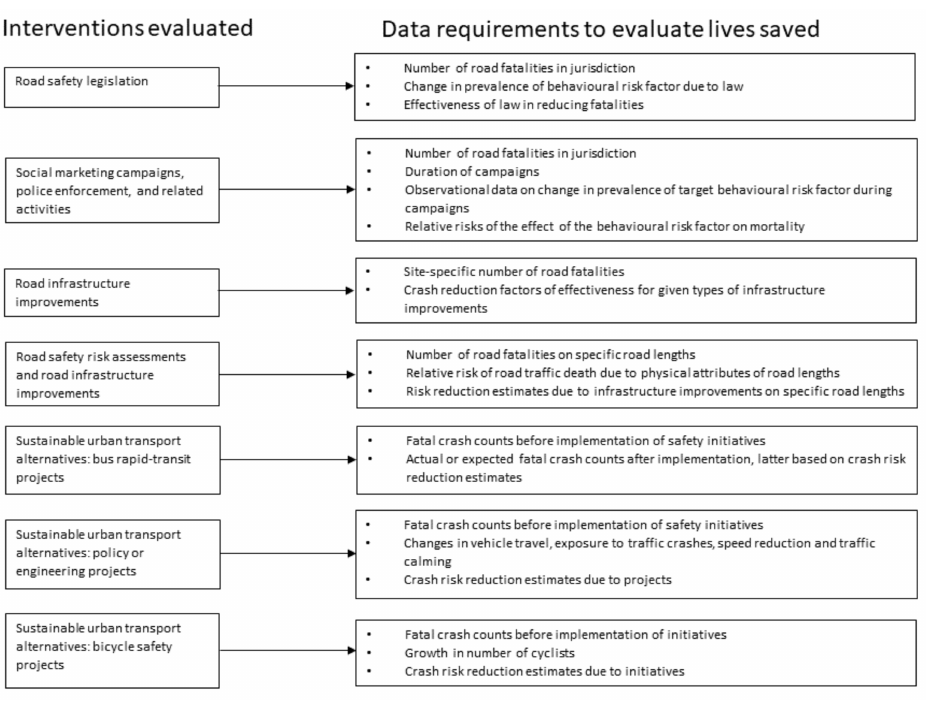
Figure 2. Data requirements to evaluate lives saved by intervention